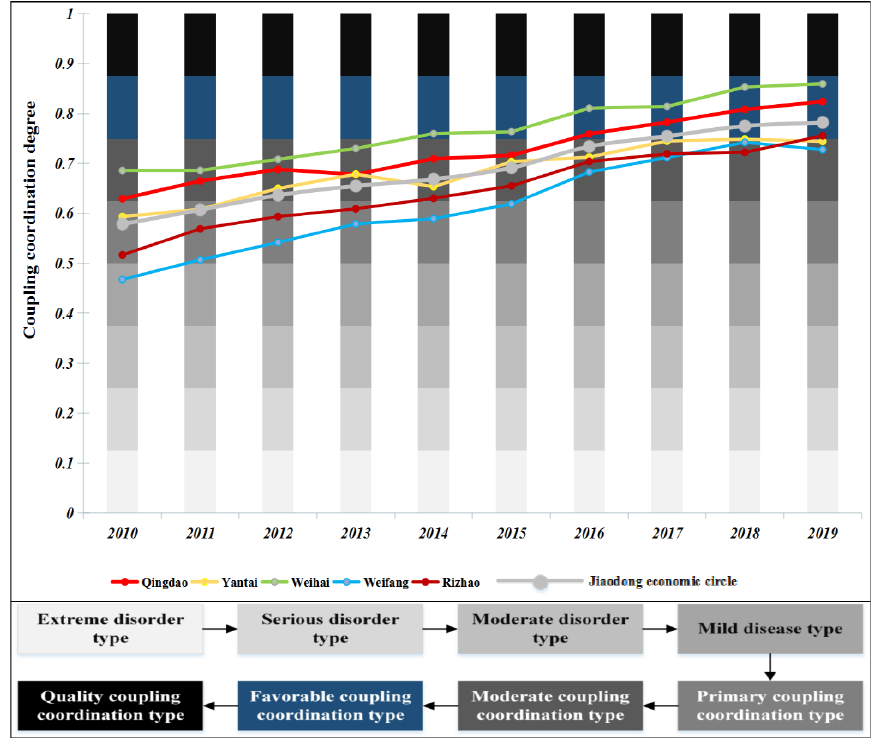
Figure 7. Timeseries of the coupling coordination degree of 5 cities and the entire Jiaodong Eco- nomic Circle.